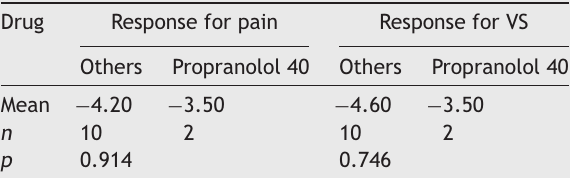
Comparison between therapeutic response mea- sured by VAS variation in hypertensive patients receiving (cid:2) -blocker drug prophylaxis and hypertensive patients receiv- ing other drugs.